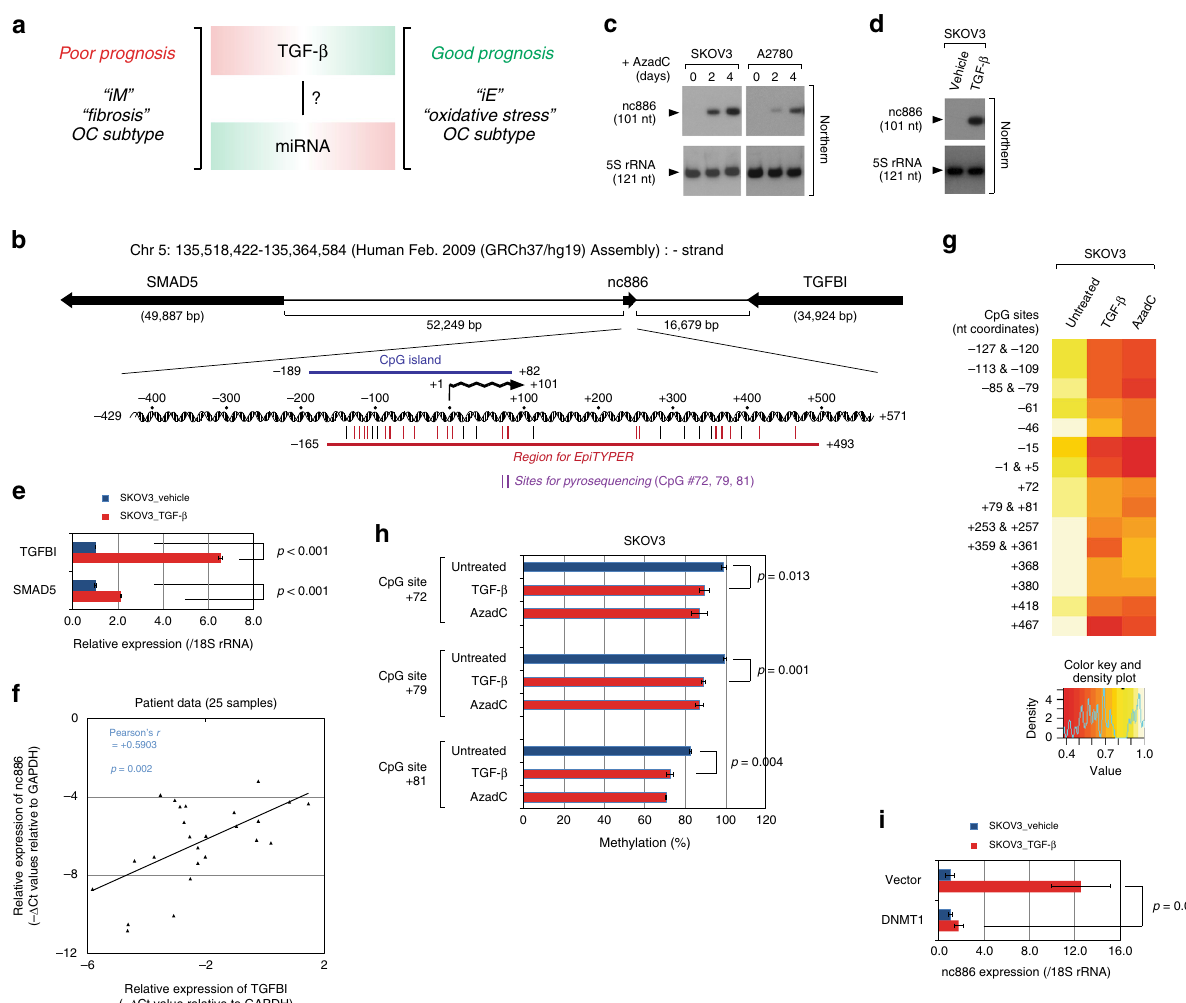
Fig. 1 nc886 is epigenetically silenced but induced by TGF- β . a A model depicting the opposite tendency of TGF- β and miRNA activities in OC subtypes. The gradient of red to green colors indicates high to low activity. b A diagram showing the nc886 genomic region in chromosome 5. A wide nc886 locus spanning its fl anking genes is on the top and a 1000-nt region is shown magni fi ed on the bottom. The arrows indicate transcriptional direction. All symbols (nc886 RNA, wavy line; CpG island, blue bar; EpiTYPER region, dark magenta bar) on the magni fi ed view are drawn to exact scale, with their nt coordinates counted based on the 5 ′ -end of nc886 being + 1. Among CpG sites (vertical bars), the ones measured by EpiTYPER and pyrosequencing are designated as dark magenta and purple, respectively. c Northern hybridization after treatment of AzadC at 10 µ M. d , e Northern hybridization ( d ) and qRT-PCR ( e ) of indicated genes. f A scatter plot of nc886 and TGFBI expression values from 25 OC patients from the Cheil hospital. g , h A heat map view of EpiTYPER data for all measurable CpG sites ( g ) and pyrosequencing of indicated CpG sites ( h ). AzadC and TGF- β were treated for 96 h. All other descriptions are the same as ( b – e ). i qRT-PCR of nc886. DNMT1-expressing plasmid (and vector control) was transfected at 48 h post treatment of TGF- β at 10 ng ml -1 .